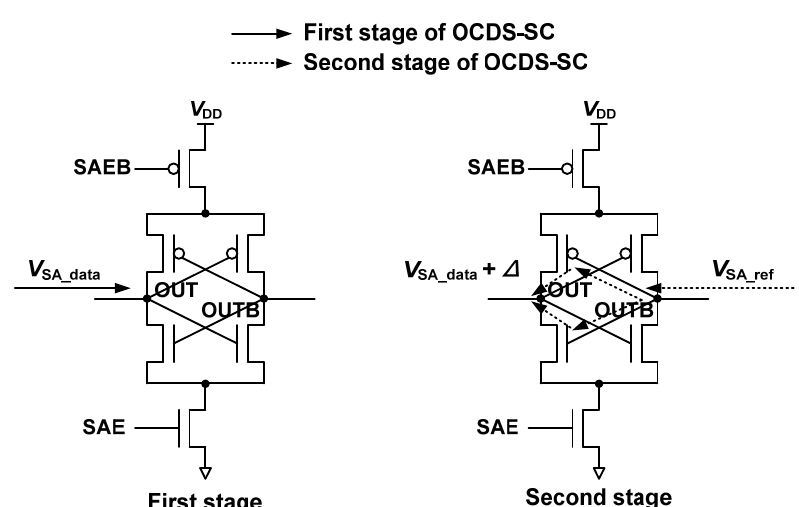
Figure 3. Capacitive coupling problem when voltage-latched SA (VLSA) is used.